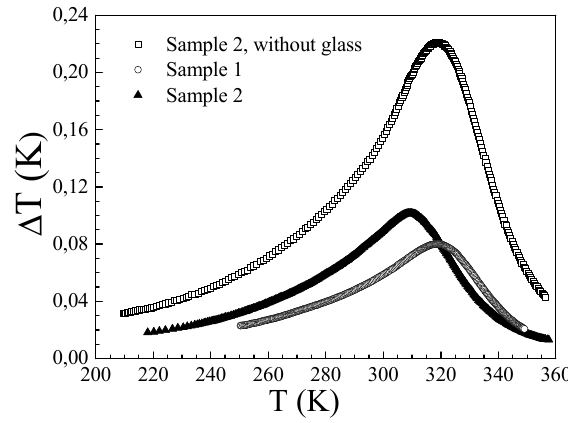
Figure 46. Temperature dependence of the magnetocaloric effect, ∆ T , in Heusler-type Ni-Mn-Ga glass-coated microwires annealed at 823 K for ∆ H = 18 kOe. Reproduced from reference [26], Figure 5. Observed MCE might be associated with magnetic (paramagnetic-ferromagnetic) and probably structural (austenite-martensite) transitions. Temperatures of the peak values of the MCE were found to be ~318 K and ~309 K,